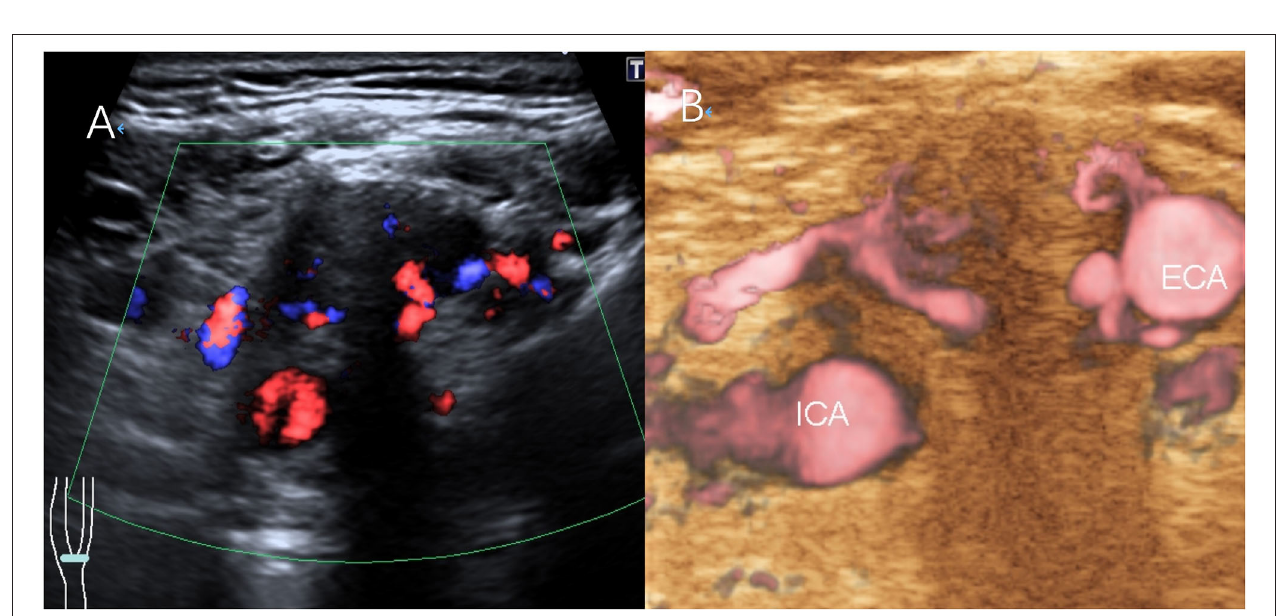
FIGURE 2 | Scans from a 38-year-old man with a right CBT lesion measuring 3.8cm. (A) CDFI of the lesion. (B) The feeding artery of the CBT on SMI.